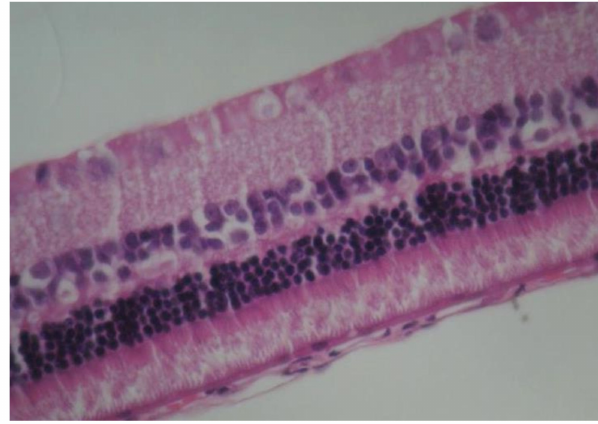
Figure 12. Group M. No pathological changes were observed in the retina. EH. ×